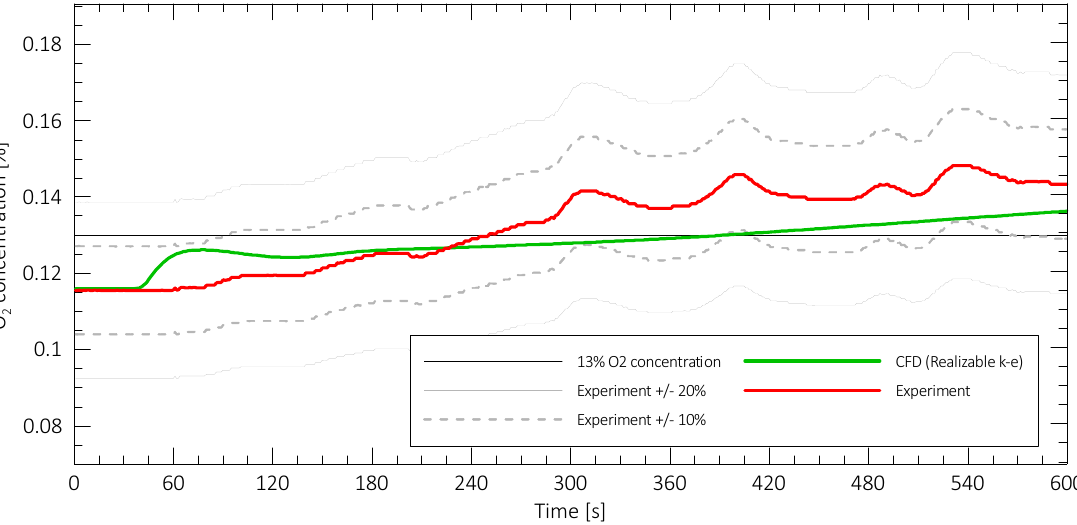
Figure 17. Changes in oxygen concentration (v/v) on the probe No. 1, indicating the end of the retention time during experimental tests and CFD simulations, fire-extinguishing gas Ar 7.8% v/v and N 2 92.2% v/v.